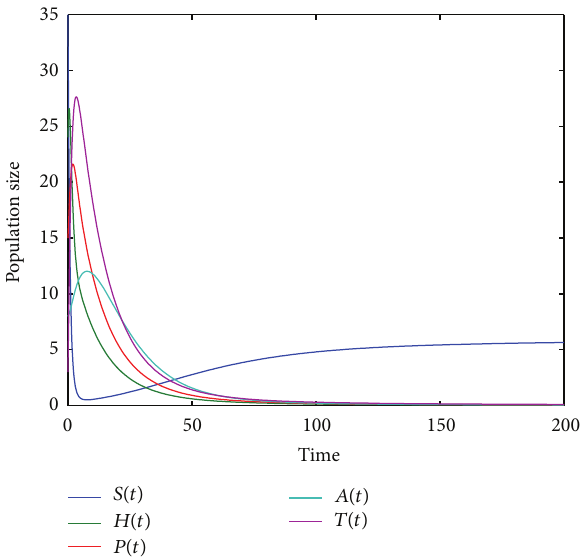
Figure 3: When 𝑘 3 = 0.51086 , 𝑘 4 = 0.4 , and 𝑅 0 = 1 , the disease-free equilibrium is globally asymptotically stable.